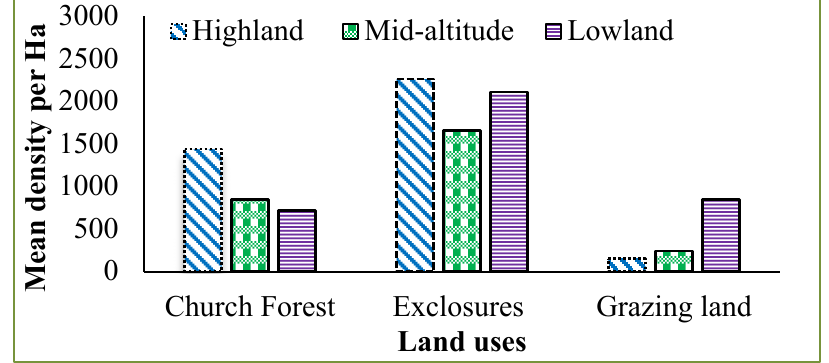
Figure 2. Woody species density.